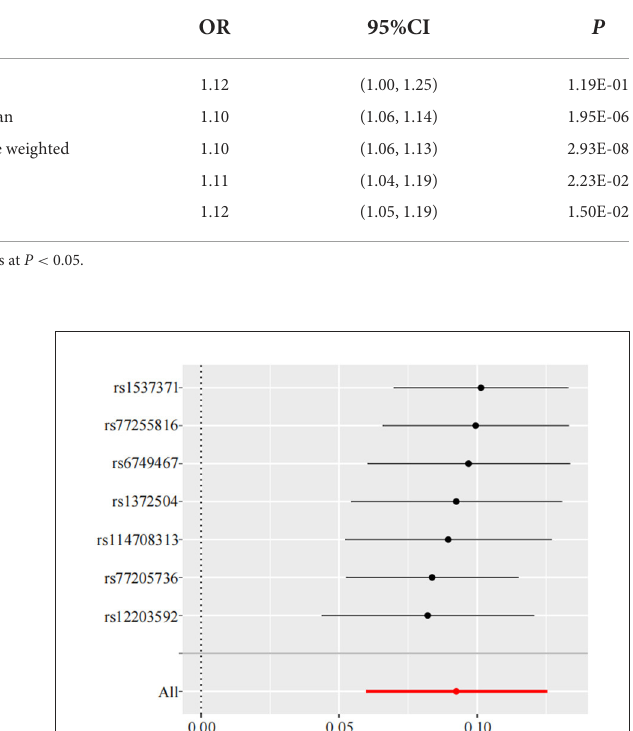
FIGURE3 Forest plot of PM 2.5 associated with risk of hypothyroidism. The x-axis shows the MR effect size for PM 2.5 on hypothyroidism. The y-axis shows the analysis for each of the SNPs. MR, Mendelian randomization; PM 2.5 , particulate matter 2.5; SNP, single nucleotide polymorphism.